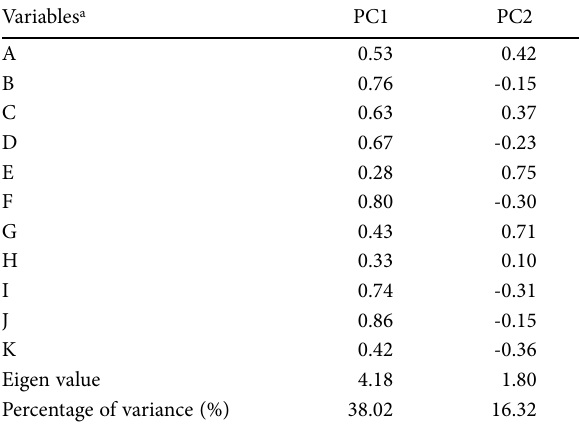
Table 8. Eigen vectors of the two principal components axes (PC1 and 2) for the 11 variables assessed (percentage of plants resistant to each of the 11 Puccinia striiformis f. sp. tritici pathotypes for Leb- anese landraces), and their contributions to the variance.